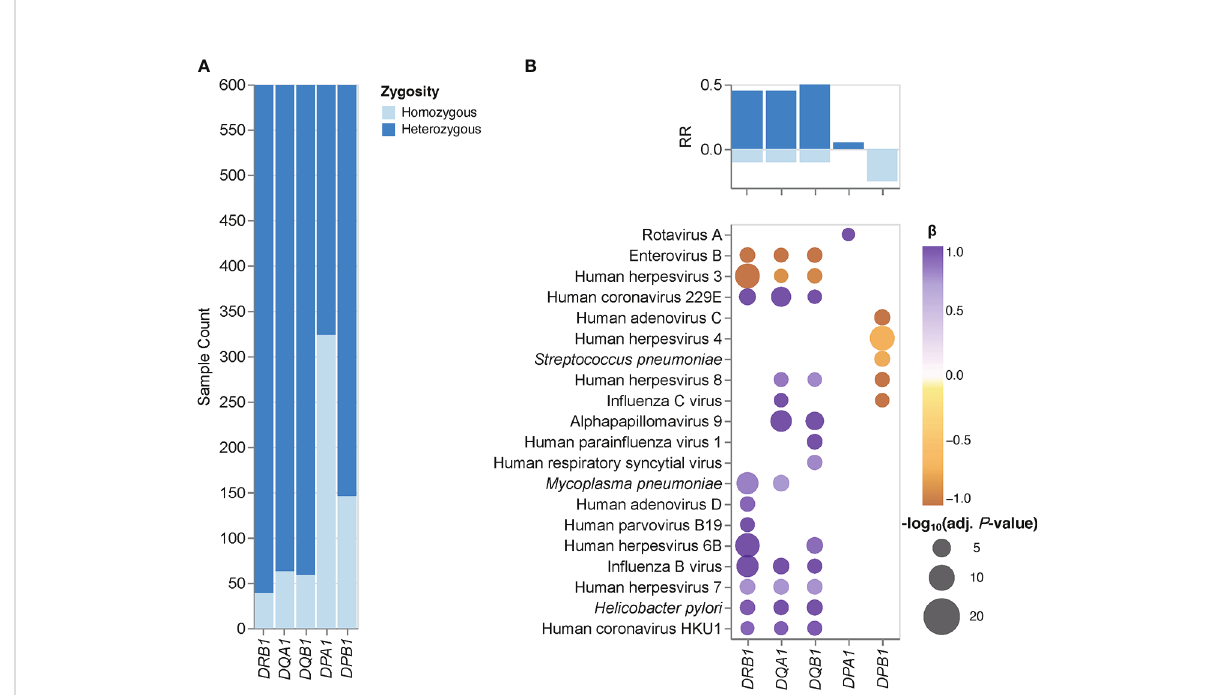
FIGURE 1 HLA class II gene zygosity effect on the antibody repertoire breadth against common microbial infections. (A) Bar plots depict the fraction of homozygous (light blue) and heterozygous (dark blue) individuals (n = 599) for each HLA class II gene tested. (B) Heatmaps depicting signi fi cant associations (adjusted P -value ≤ 0.005) between zygosity in HLA class II genes and the antibody repertoire breadth against common microbial infections. The coef fi cient ( b ) and direction of associations are indicated by a color gradient for each symbol (a positive b value indicates a positive association with a heterozygous genotype and visa versa). Bar plots depict the anti-microbial response ratio (RR) associated with a heterozygous genotype (positive values) and homozygous genotype (negative values) for each gene